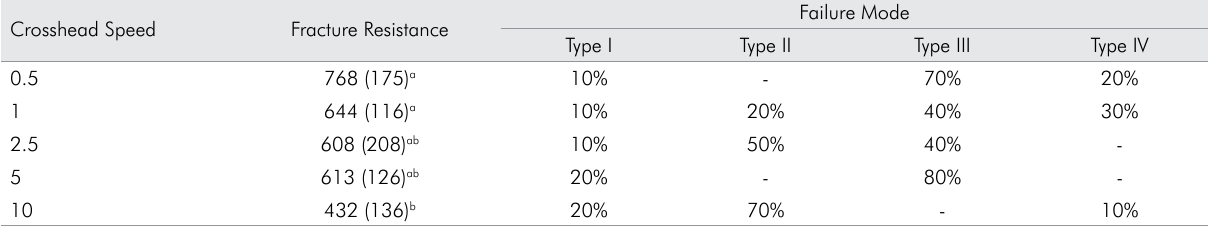
Table. Means (standard deviations) for fracture resistance (N) and distribution of failure modes. Crosshead Speed Fracture